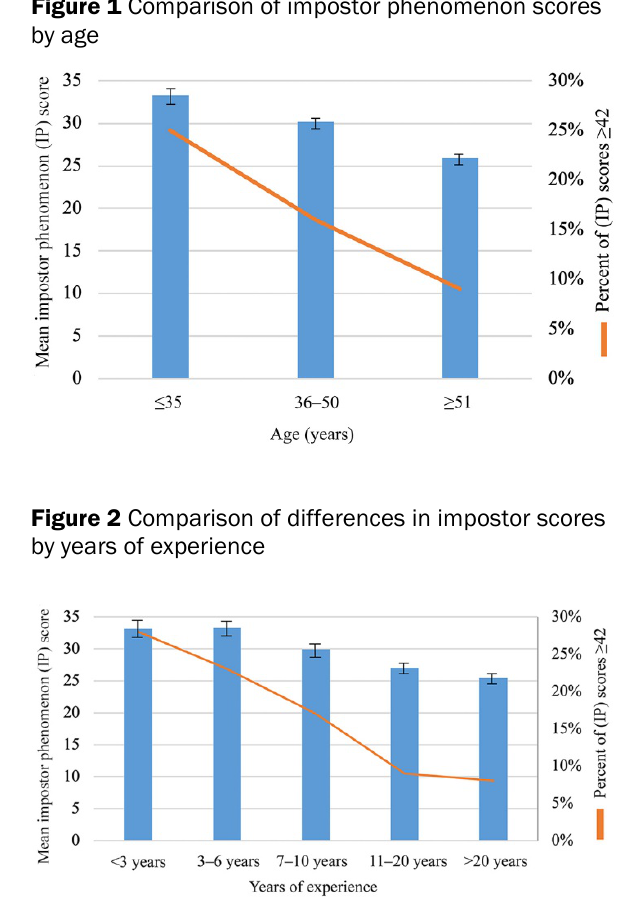
Figure 1 Comparison of impostor phenomenon scores by age